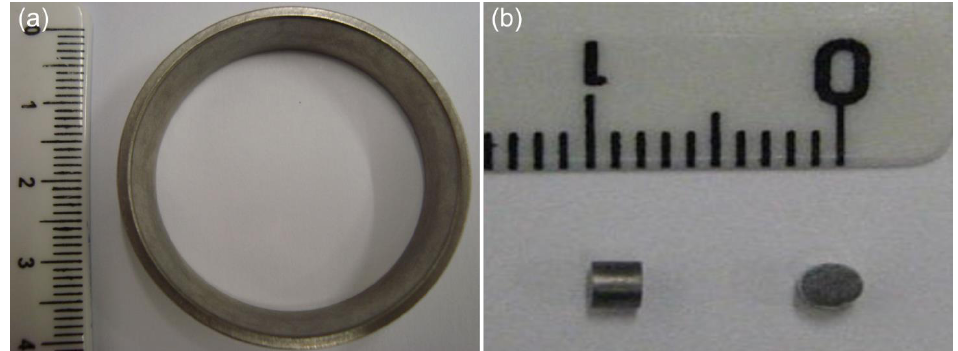
Figure 1. Exhaust valve seats: ( a ) as received from the supplier and ( b ) samples prepared for thermogravimetric analyses.